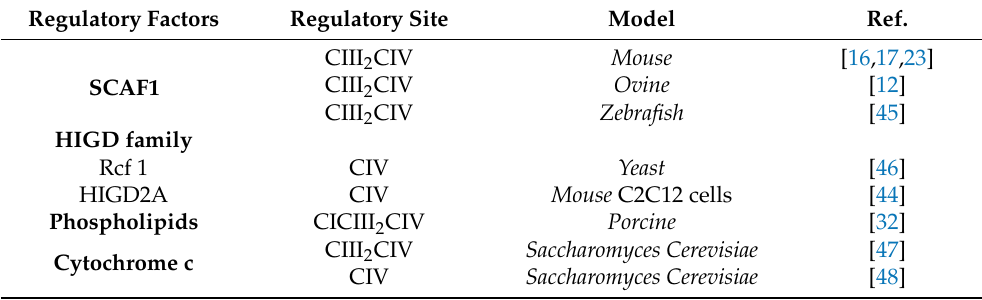
Table 3. Regulatory factors at different regulatory site of SCs in diverse